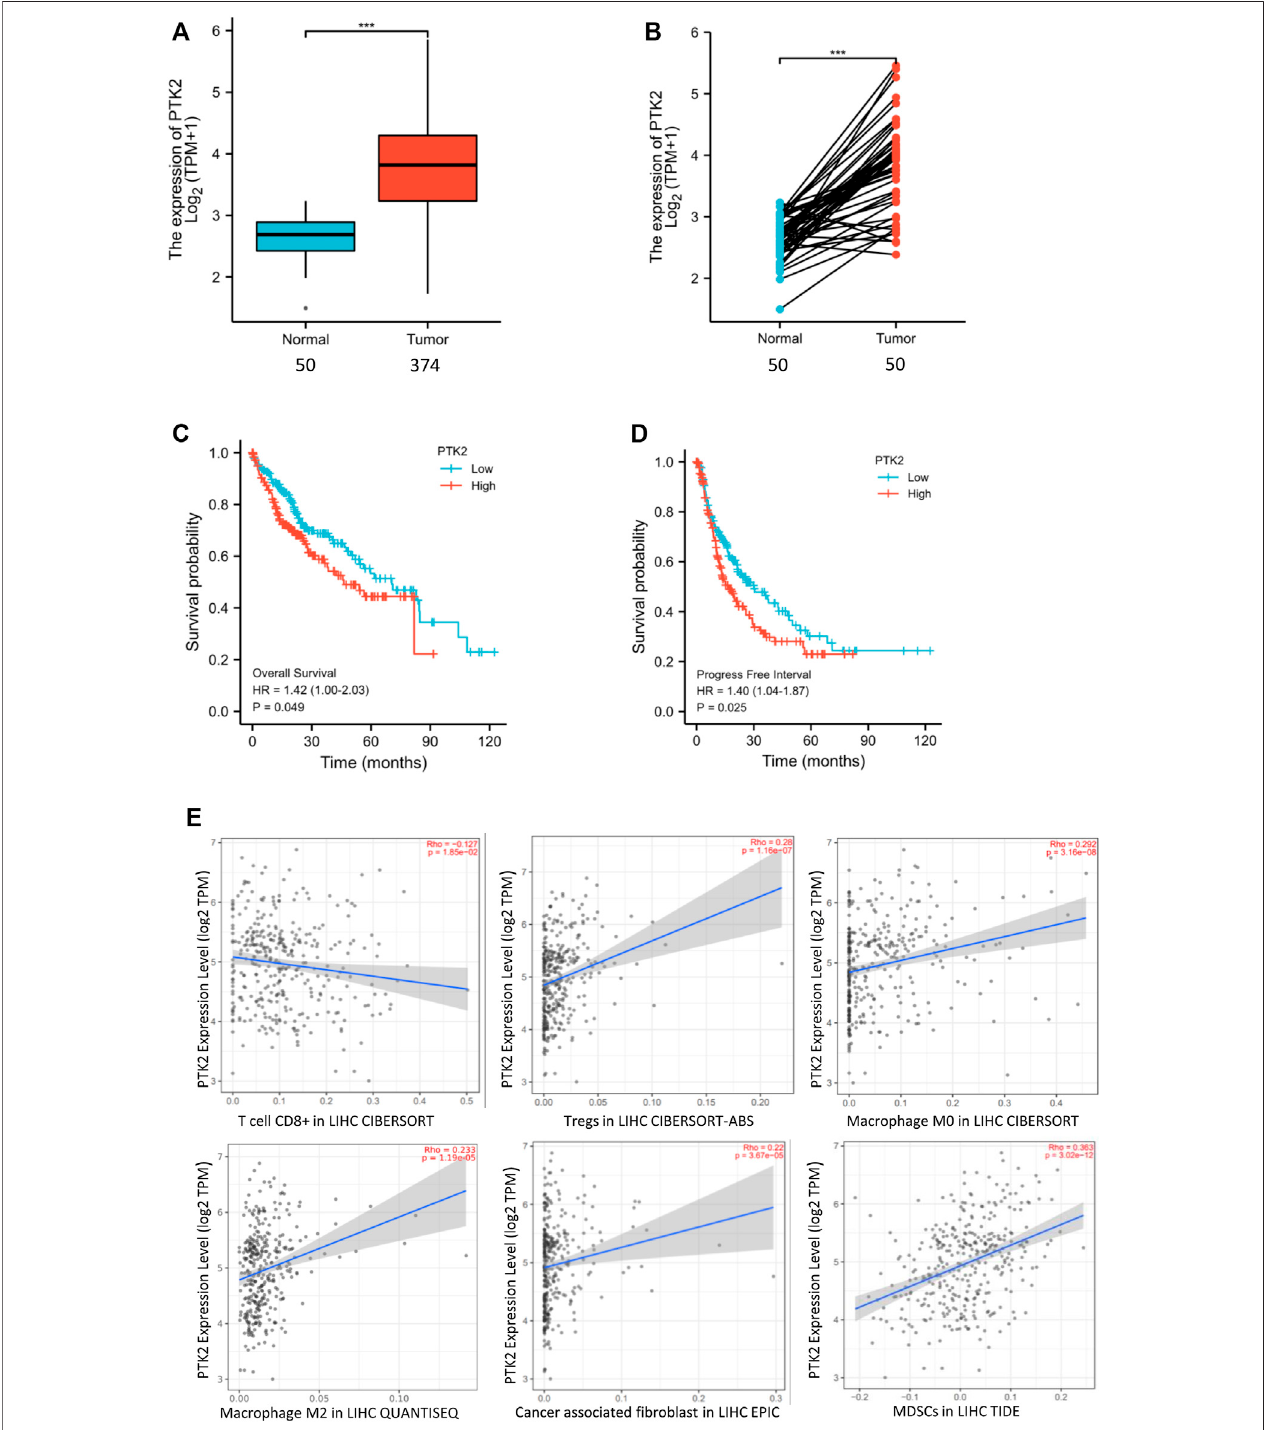
FIGURE1| HighexpressionofFAKinhumanHCCisassociatedwithpoorprognosisandanimmunosuppressiveTME (A) FAKexpressionishigherinhumanHCC tissues than in paired normal tissues by Wilcoxon rank sum test ( p < 0.001). (B) The expression of FAK signi fi cantly increased in HCC tissues compared with adjacent tissues in the paired samples with Wilcoxon signed-rank test. (C – D) Kaplan-Meier survival analysis showed that increased expression of FAK was signi fi cantly associated with poor Overall Survival ( p (cid:1) 0.049) and Progression-free survival ( p (cid:1) 0.027). (E) The relationship between FAK expression and CD8 + T cells(Rho (cid:1) -0.17 p (cid:1) 1.85e-2), Tregs(Rho (cid:1) 0.28 p (cid:1) 1.16e-7),M0(Rho (cid:1) 0.292; p (cid:1) 3.16e-8),M2(Rho (cid:1) 0.233; p (cid:1) 1.19e-5),CAFs(Rho (cid:1) 0.22; p (cid:1) 3.67e-5) and MDSCs(Rho (cid:1) 0.363; p (cid:1) 3.02e-12).Signi fi cance identi fi cation: ns, p ≥ 0.05; *, p < 0.05; **, p < 0.01; ***, p < 0.001.